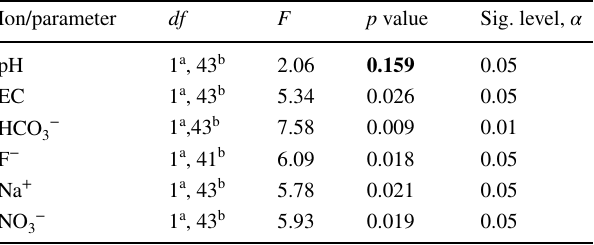
Table 4 One-way ANOVA, single-factor results comparing spring and well waters